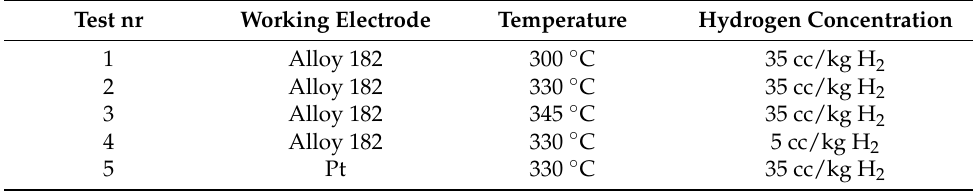
Table 2. Test matrix of the impedance